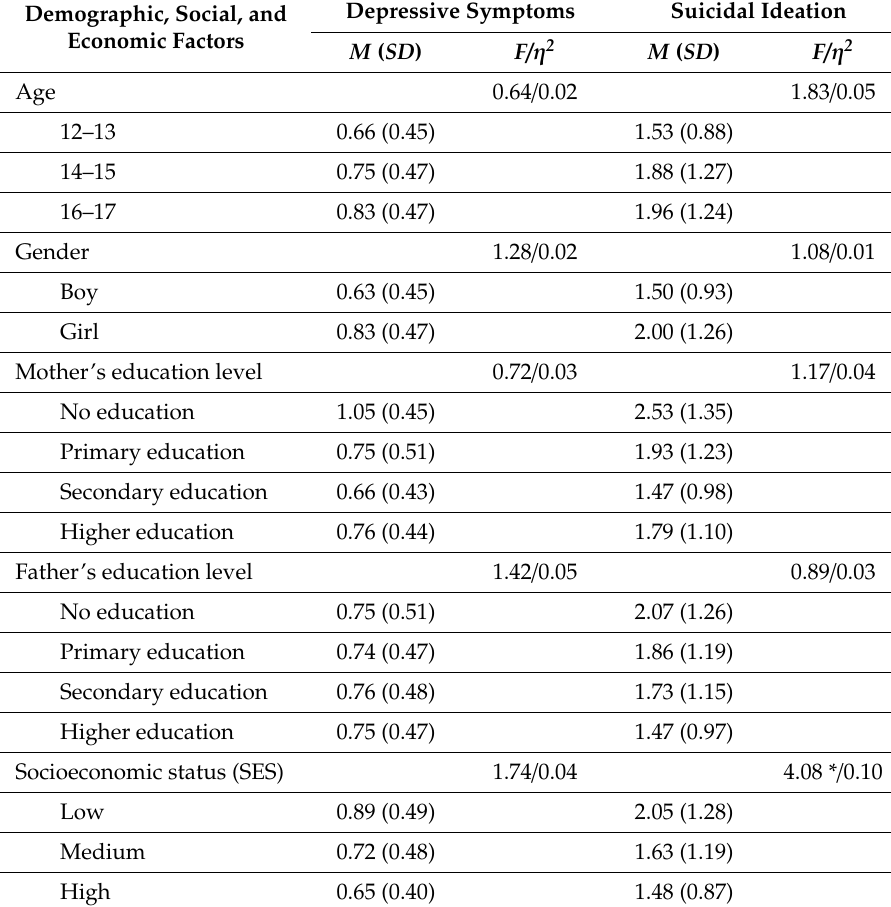
Table 3. Multivariate analysis of variance (MANOVA) for the referred sample ( n = 211). Demographic, Social,